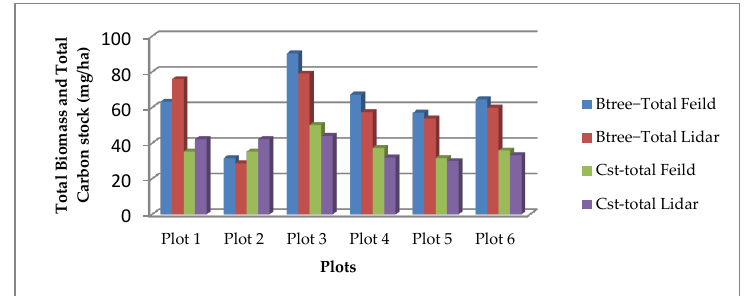
Figure 14. Total Biomass and carbon stock (Mg/ha) for the six plots. Where B the total plot biomass, estimated in the basis of data field, in Mg/ha, B tree − Total Lidar is the total plot biomass, estimated in the basis of ALS-UAV-TLS data, C st-total Field is the total plot carbon stock, estimated in the basis of data field in Mg/ha and C st-total Lidar is the total plot carbon stock, estimated in the basis of ALS-UAV-TLS data in